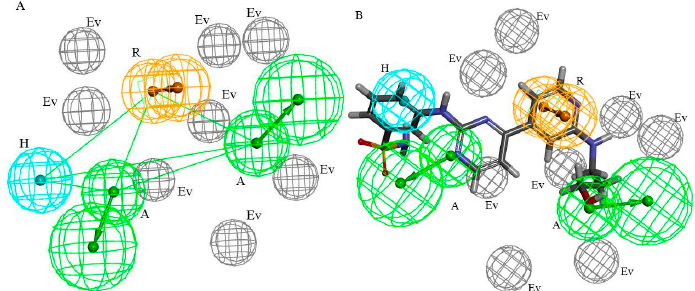
Figure 3. The best HipHop pharmacophore model of CDK2 ATP-competitive inhibitors ( A ) and the compound BDBM50394183 mapped with model Hypo1-1 ( B ).